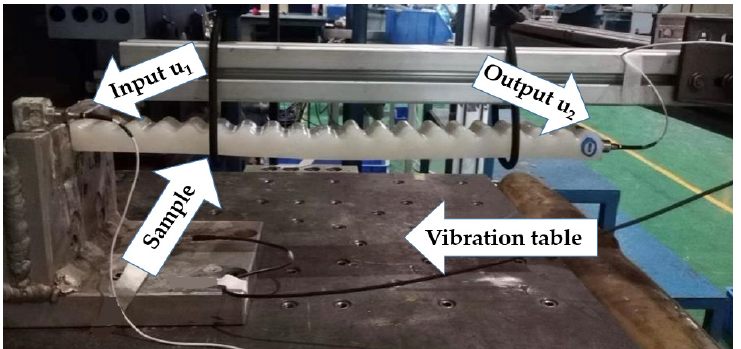
Figure 10. Schematic diagram of vibration test system.